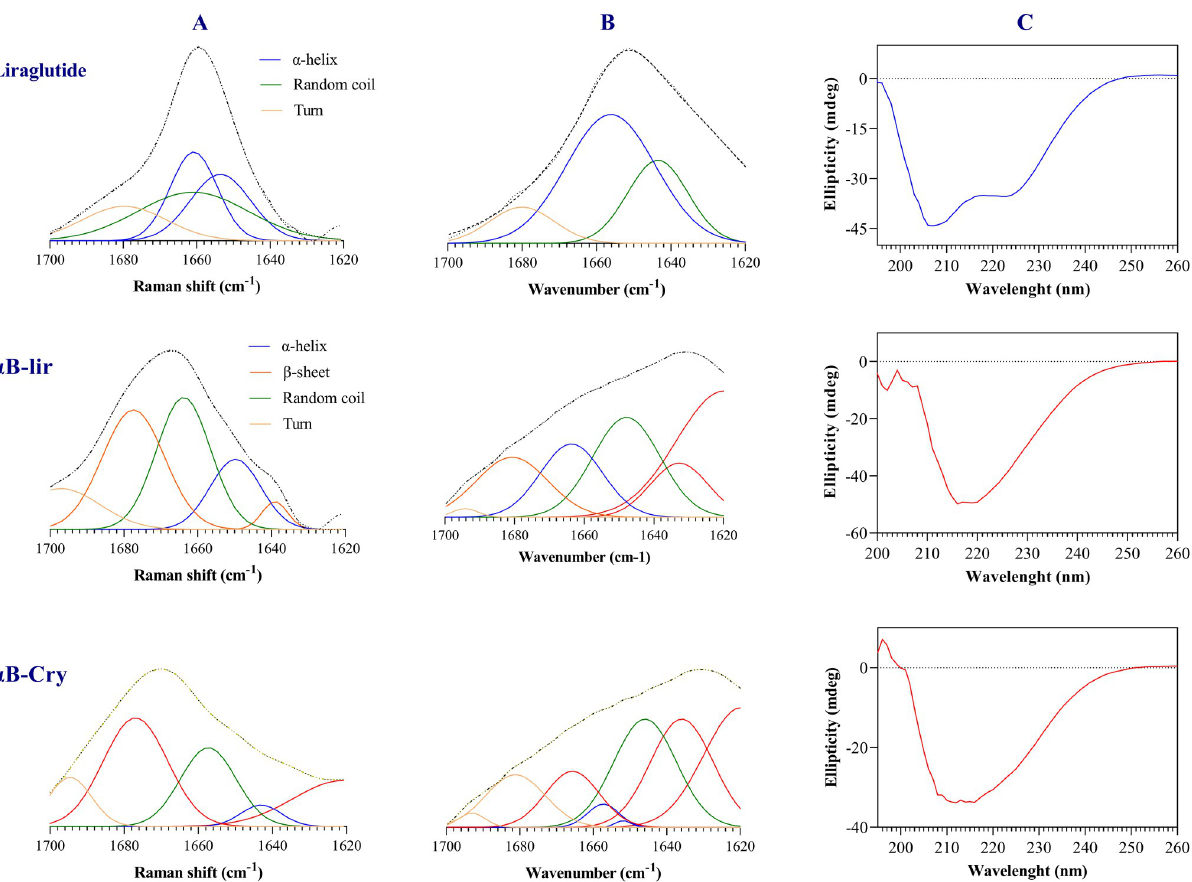
Fig 5. The secondary structure analyses of LPP and α B-lir. For the analyses of the secondary structures, three different methods as Raman ( A ), ATR-FTIR ( B ) and far UV-CD ( C ) were applied. During the Raman and FTIR assessments, the samples were used as powder while the amide band I was deconvoluted by GRAMS (version 9.2) [38]. In the far UV-CD analyses, the LPP was dissolved in phosphate buffer pH 8.1, while α B-lir and α B-Cry were prepared in 100 mM acetate buffer, pH 5.2. In the far UV-CD assessments, the protein/peptide concentration was fixed at 0.2 mg/mL, and the data were deconvoluted by DichroWeb [43]. The upper, middle and lower panels respectively stand for the secondary structure analyses of the LPP, α B-lir and α B-Cry.